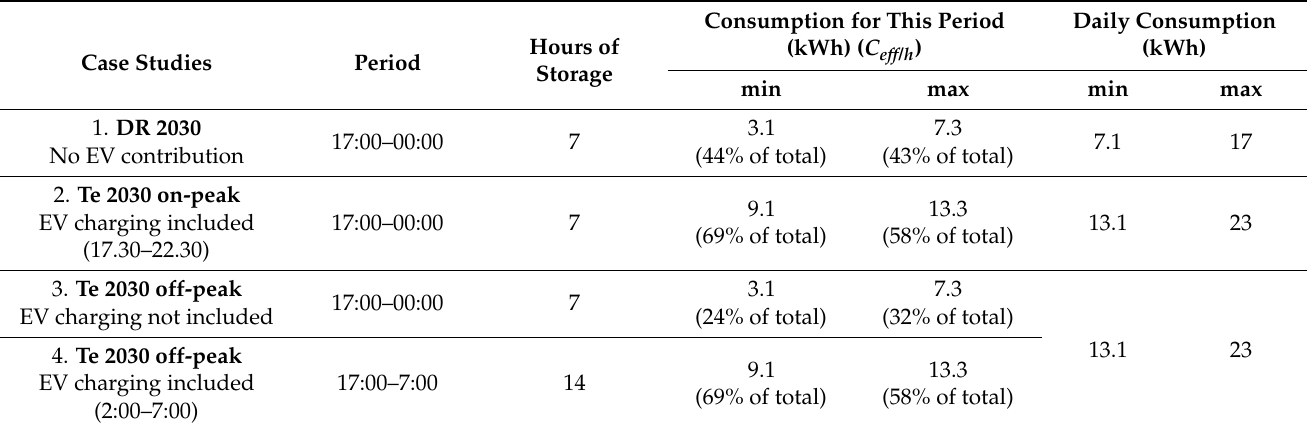
Figure 3. Demand assumptions and assumed hours of storage discharge for DR 2030 and Te 2030 scenarios. Note the effects of the electric vehicle charging process in Te 2030 off-peak from 2:00–7:00 and Te 2030 on-peak from 17:30–22:30. The recharge of the battery is assumed to occur at some time between 07:00 and 17:00. Table 1. Case studies for electricity storage during the